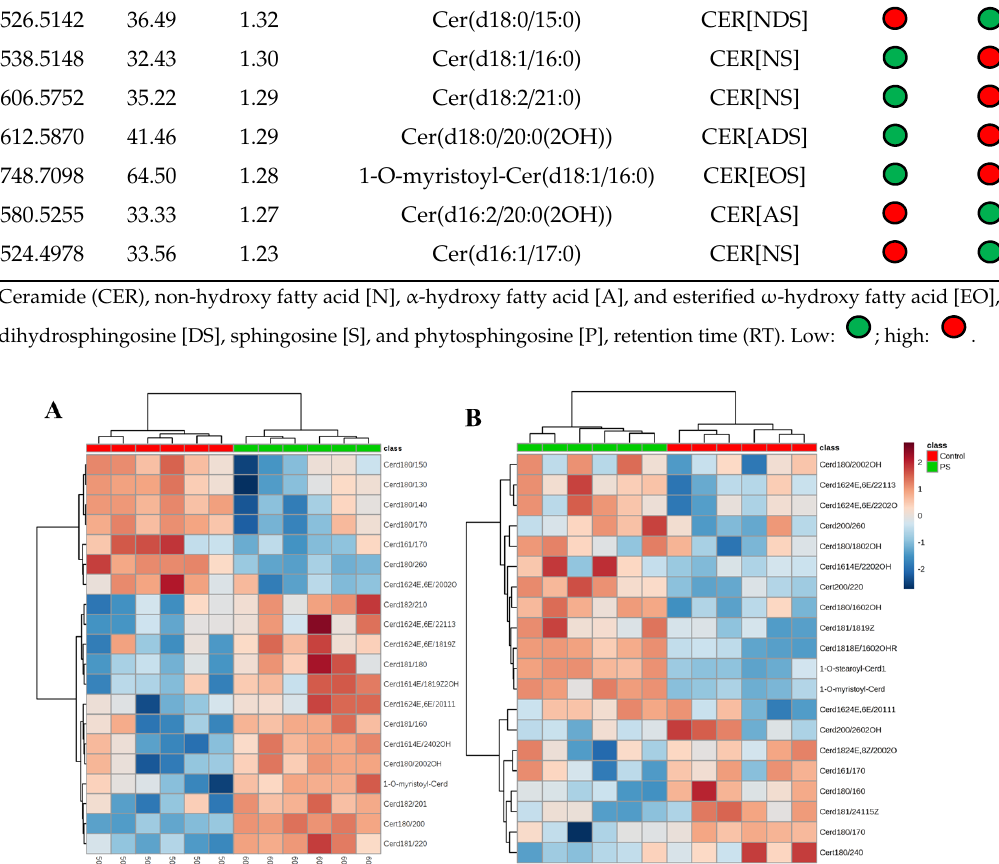
Figure 5. Two-dimensional hierarchical clustering heat map of the 20 CERs selected according to the VIP list in the keratinocytes ( A ) and fibroblasts ( B ). Relative abundance levels are indicated on the colour scale, with numbers indicating the fold di ff erence from the overall average. The clustering of the sample groups is represented by the dendrogram at the top. The clustering of individual CER species with regard to their similarity in the change of relative abundance is represented by the dendrogram on the